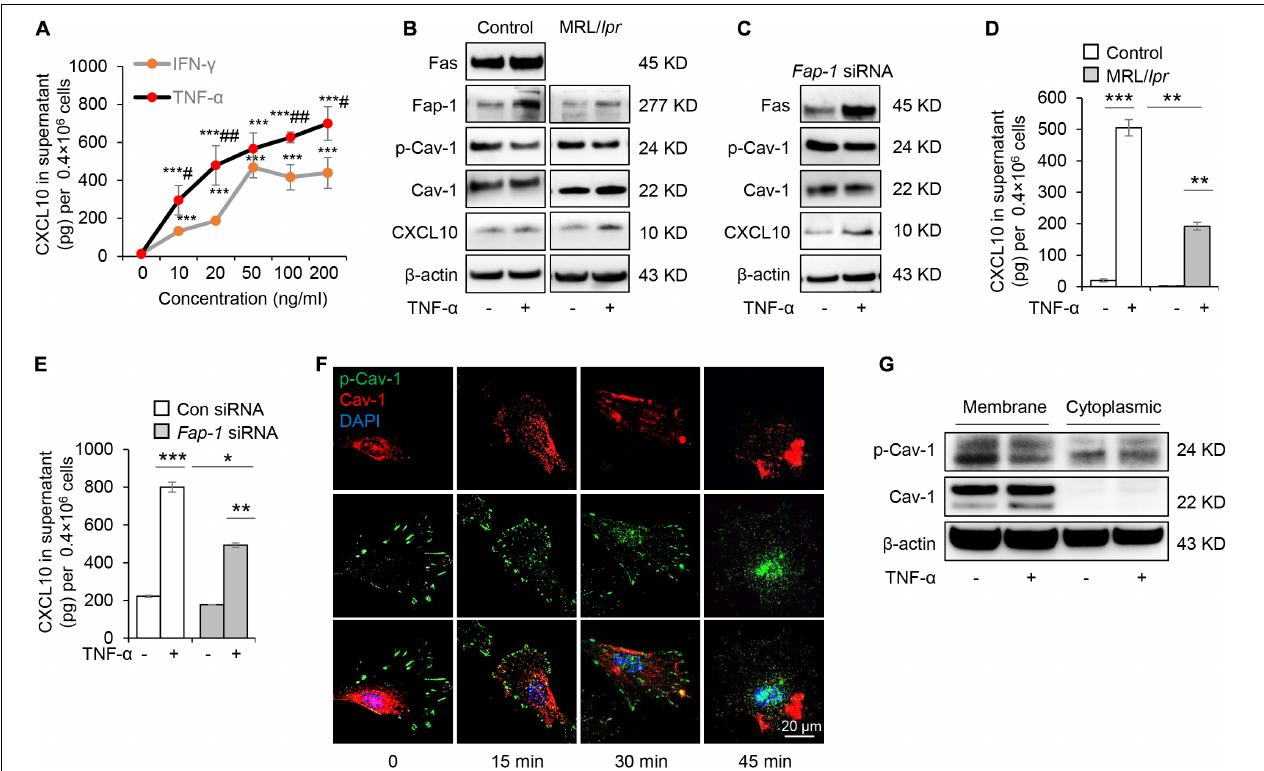
FIGURE 6 | Tumor necrosis factor- α TNF- α up-regulates Fas and Fap-1 to dephosphorylate Cav-1 to activate CXCL10 secretion in murine GMSCs. (A) ELISA analysis of CXCL10 secretion in the culture supernatant from WT GMSCs treated with indicated dose of TNF- α or IFN- γ . *** P < 0.001, TNF- α or IFN- γ treated GMSCs versus control; # P < 0.05, ## P < 0.01, TNF- α treated GMSCs versus IFN- γ treated GMSCs. (B) Western blotting analysis of Fap-1, Fas, p-Cav-1, Cav-1, CXCL10 protein expression of WT GMSCs and MRL/ Lpr GMSCs with or without TNF- α (20 ng/ml) treatment. (C) Western blotting analysis of Fap-1, Fas, p-Cav-1, Cav-1, CXCL10 expression of control and Fap-1 siRNA-treated GMSCs with or without TNF- α (20 ng/ml) treatment. (D) ELISA analysis of CXCL10 secretion in the culture supernatant from WT GMSCs, MRL/ lpr GMSCs with or without TNF- α (20 ng/ml) treatment for 48 h. ** P < 0.01, *** P < 0.001. (E) ELISA analysis of CXCL10 secretion in the culture supernatant from control and Fap-1 siRNA-treated GMSCs with or without TNF- α (20 ng/ml) treatment for 48 h. * P < 0.05*, ** P < 0.01, *** P < 0.001. (F) Immunocytofluorescence staining of GMSCs at various time points after TNF- α (20 ng/ml) treatment. p-Cav-1 (green) translocation from the cell membrane to the cytoplasm was indicated. Scale bar, 20 µ m. (G) Western blotting analysis of protein expression of p-Cav-1, Cav-1 in cell membrane and cytoplasm. The results confirmed the translocation of p-Cav-1 from the cell membrane to cytoplasm upon TNF- α treatment. All results are representative of data generated in at least three independent experiments. Error bars are means ± SD. Data were analyzed using independent unpaired two-tailed Student’s t